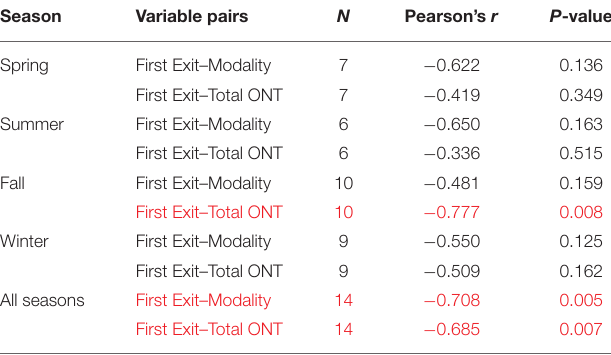
TABLE 4 | Linear correlations between the timing of first exits and modality (number of nest exits per day) and timing of first exits and total time spent outside of the nest per 24h (total